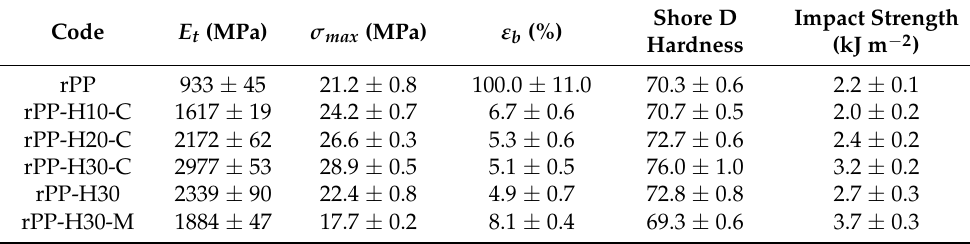
Shore D Impact Strength Hardness (kJ m − 2 )